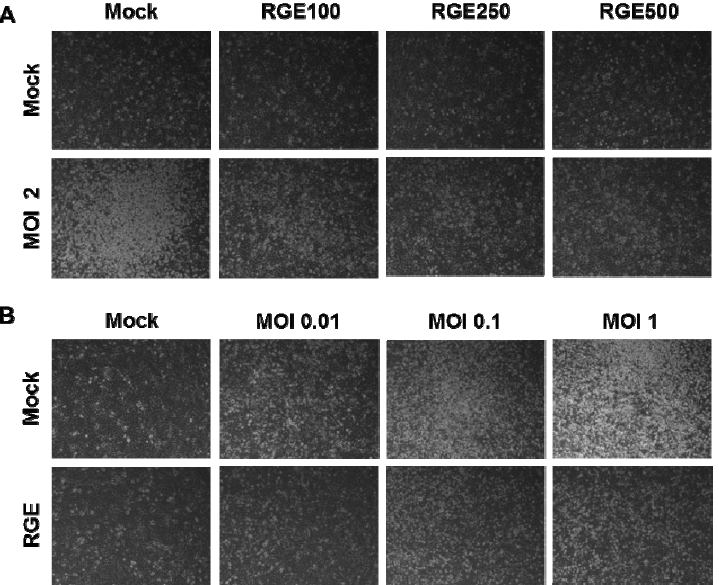
Figure 2. Representative pictures of CPE formation in A549 cells infected with H1N1 influenza A virus at different multiplicities of infection (MOIs) without or with RGE. A549 cells were mock-infected or infected with H1N1 influenza A virus at different MOIs 48 h post infection. A549 cells were continuously treated with RGE starting with 24 h pre-incubation period. ( A ) Influence of different RGE concentrations on A549 cells infected with H1N1 influenza A virus at a MOI of 2; ( B ) Influence of RGE (500 μ g/mL) on A549 cells infected with H1N1 influenza A virus at different MOI from 0 to